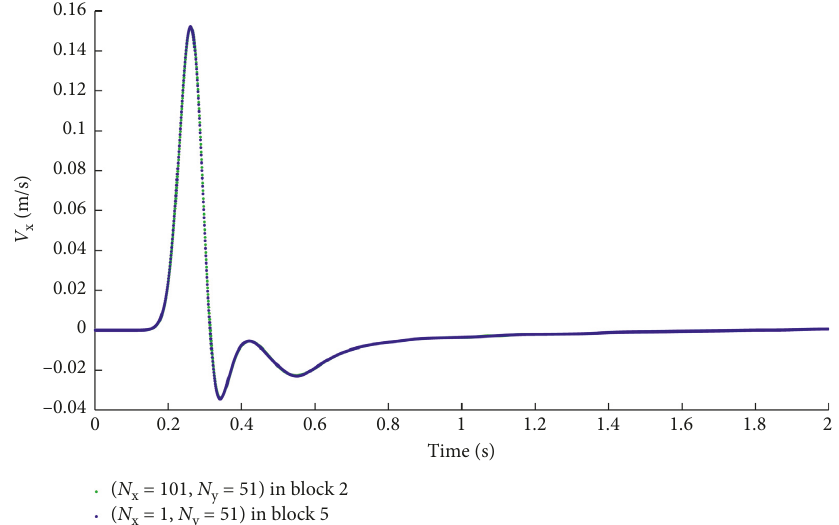
Figure 8: Velocity amplitude in the x direction.